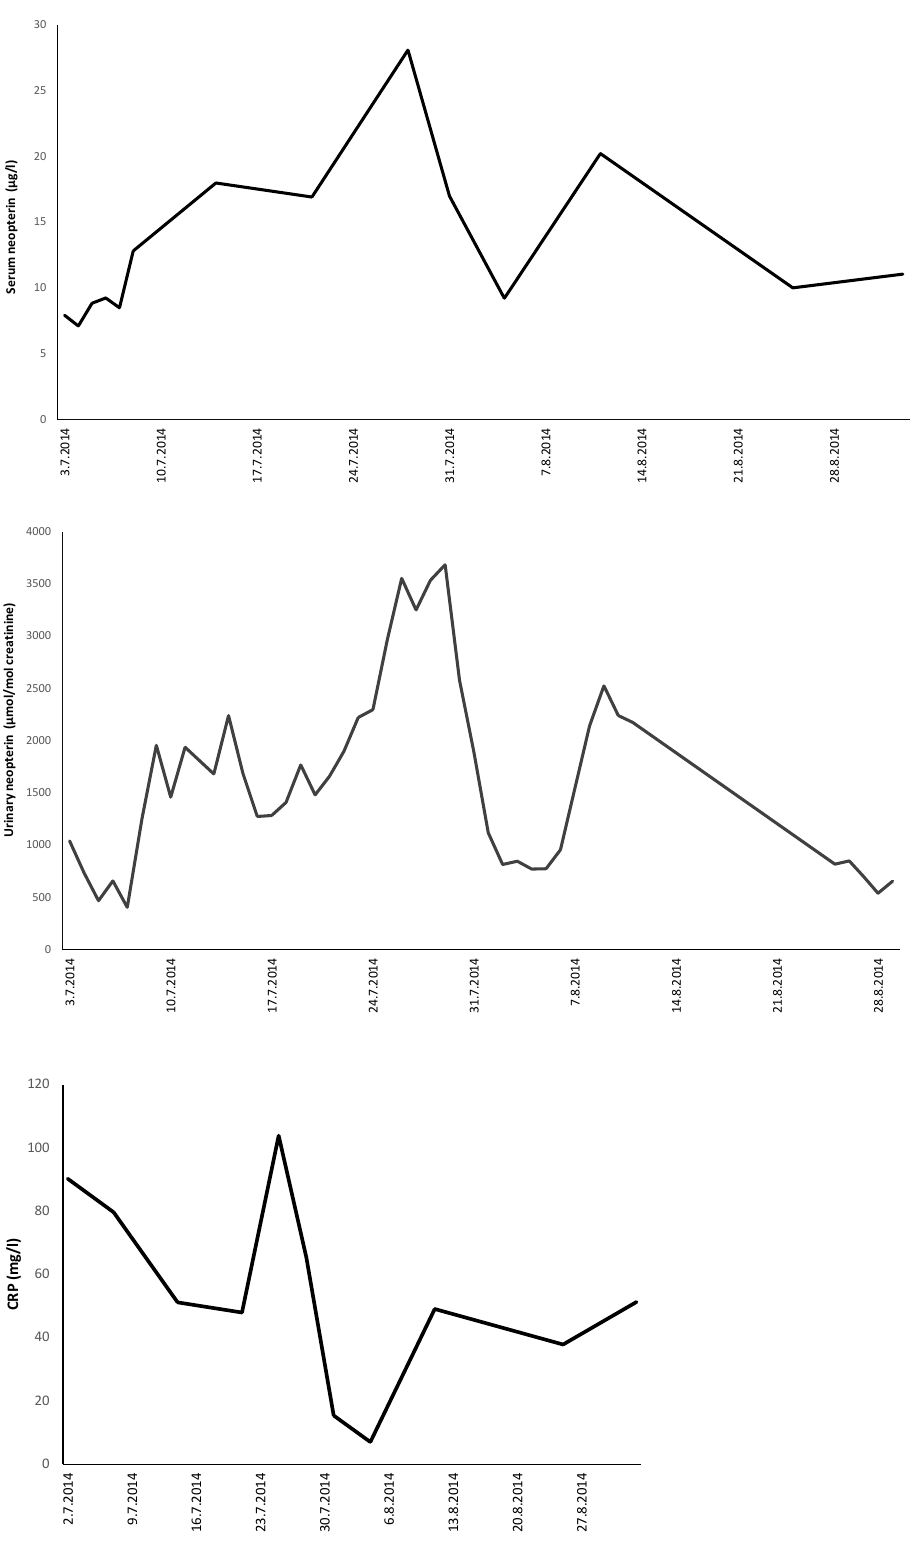
Figure 3: (A) Serum neopterin concentrations during the course of treatment. (B) Urinary neopterin concentrations during the course of treatment. (C) Serum C-reactive protein concentrations during the course of